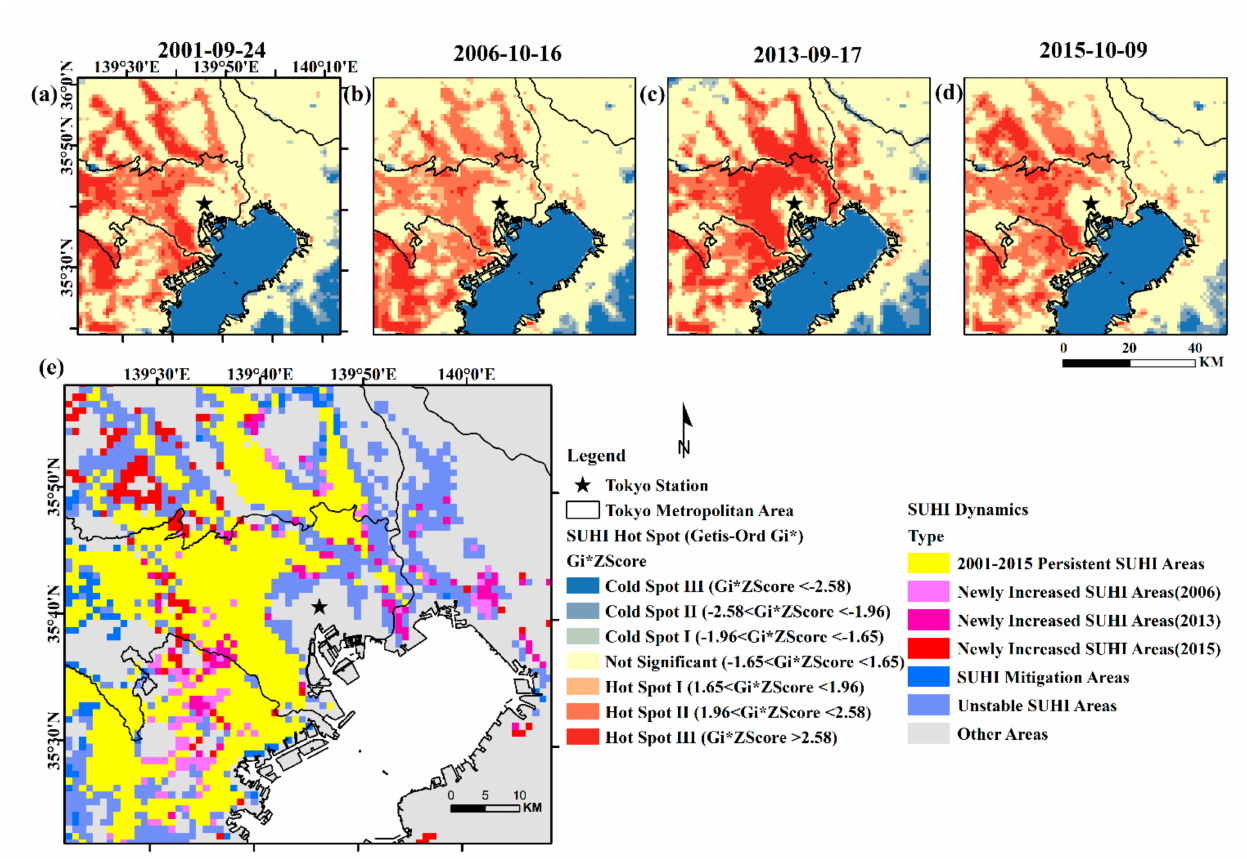
Figure 7. Spatial identification of SUHII aggregation pattern in TMA, 2001–2015: ( a ) in 2001, ( b ) in 2006, ( c ) in 2013, ( d ) in 2015, and ( e ) spatiotemporal dynamics from 2001 to